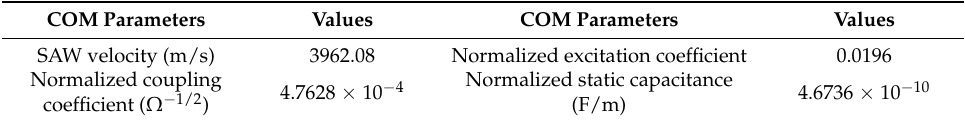
Table 1. The COM parameters of the Love wave device at optimum SiO 2 thickness of 0.23. COM Parameters Values COM Parameters Values SAW velocity (m/s) 3962.08